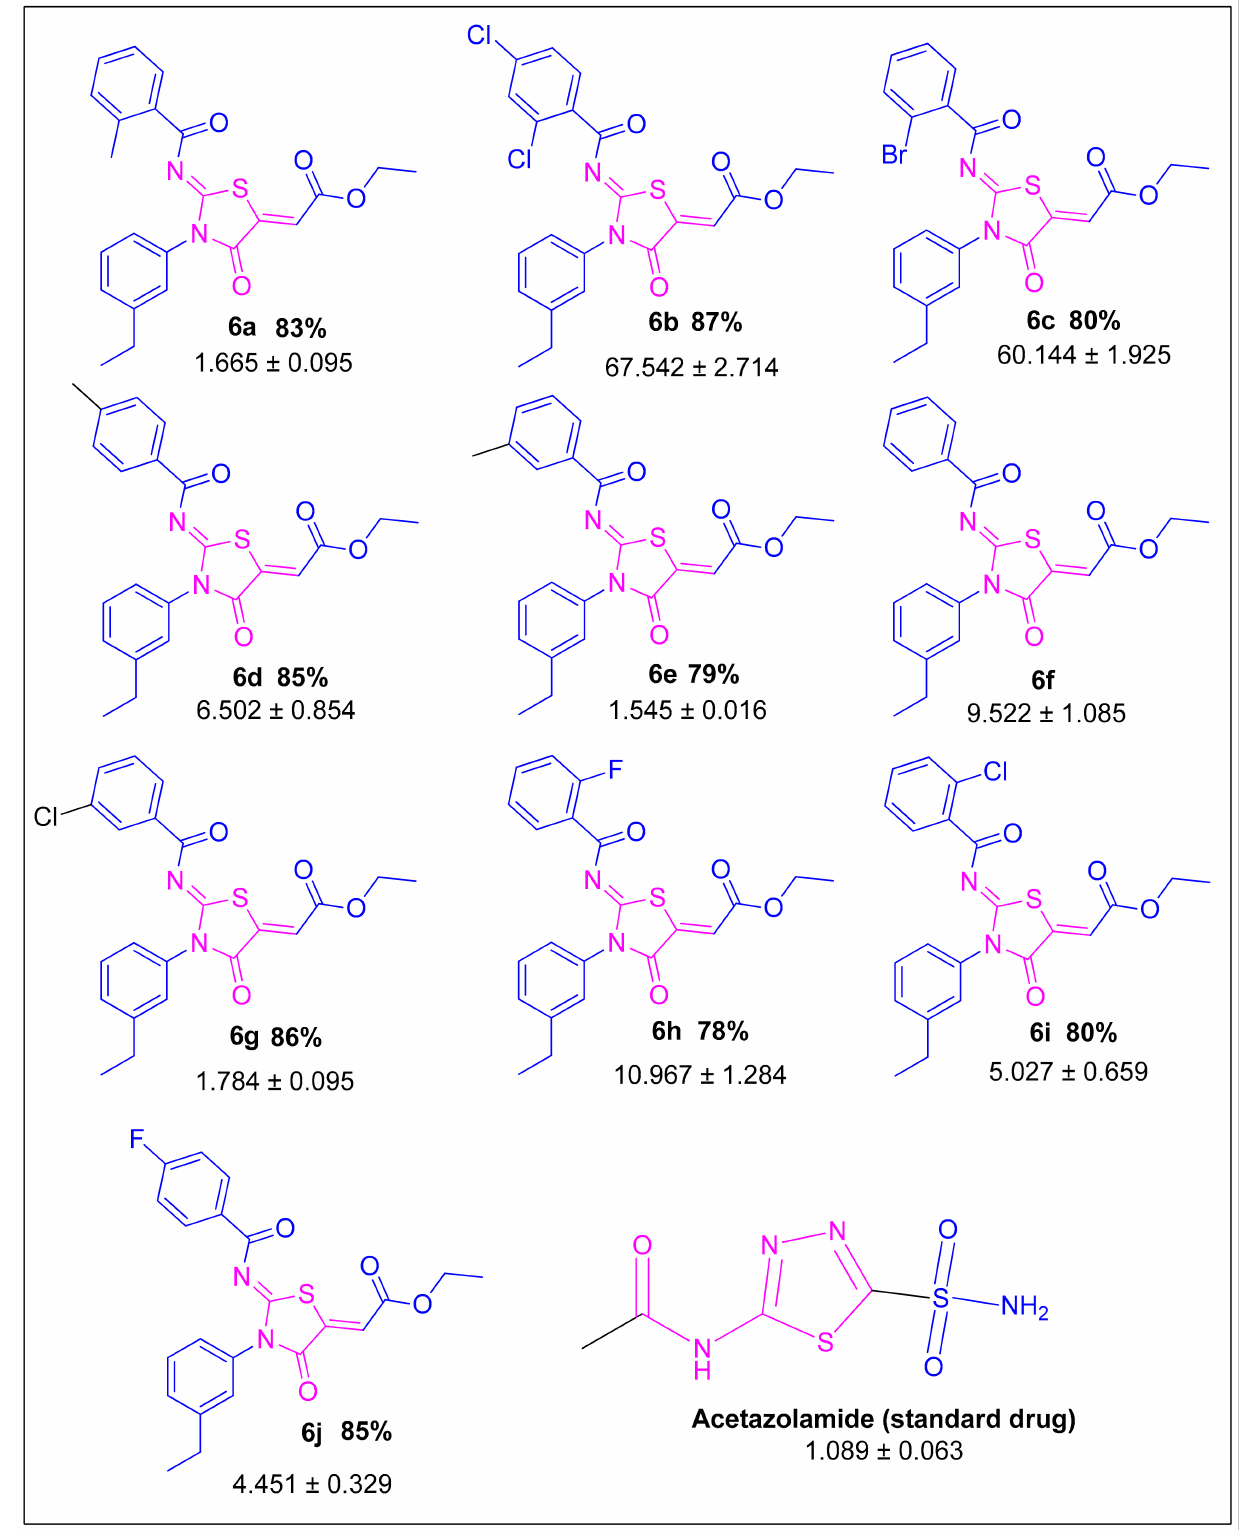
Figure 2. Chemical structures, IC 50 values and % yields of synthesized compounds ( 6a – j ) and standard inhibitor